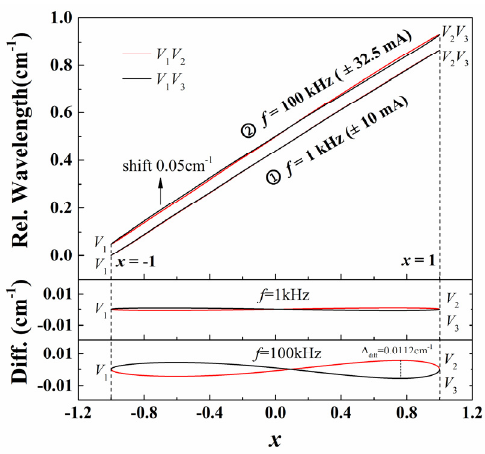
Figure 3. The relationship between laser wavelength and variable x in both V 1 V 3 and V 1 V 2 edges for different modulation frequencies 1 kHz and 100 kHz.